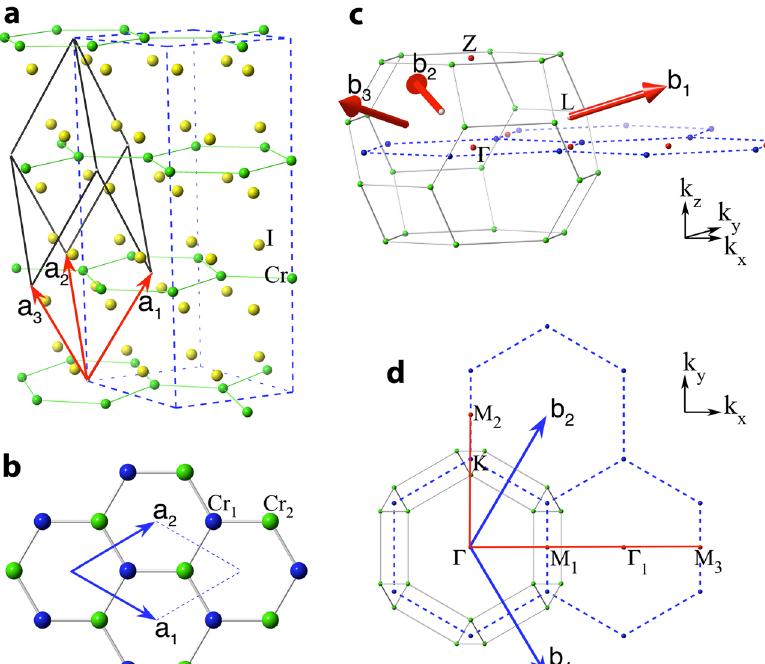
Fig. 1 Crystal structure of R-CrI 3 and corresponding BZ in comparison to hexagonal lattice. a The rhombohedral primitive unit cell and hexagonal conventional unit cell of R-CrI 3 ( R 3 , BiI 3 -type, space group no. 148). b The primitive unit cell of 2D honeycomb Cr sublattice. c The fi rst BZ and the reciprocal lattice vectors of the rhombohedral primitive cell. Along the ^ k z direction, the rhombohedral BZ boundary Z is denoted as (0.5, 0.5, 0.5) in rhombohedral notation or (0, 0, 1.5) in hexagonal notation. Dashed lines denote the BZ of the 2D hexagonal lattice. d The top view of c . Vectors b 1 and b 2 are the reciprocal lattice vectors of the 2D hexagonal lattice shown in b